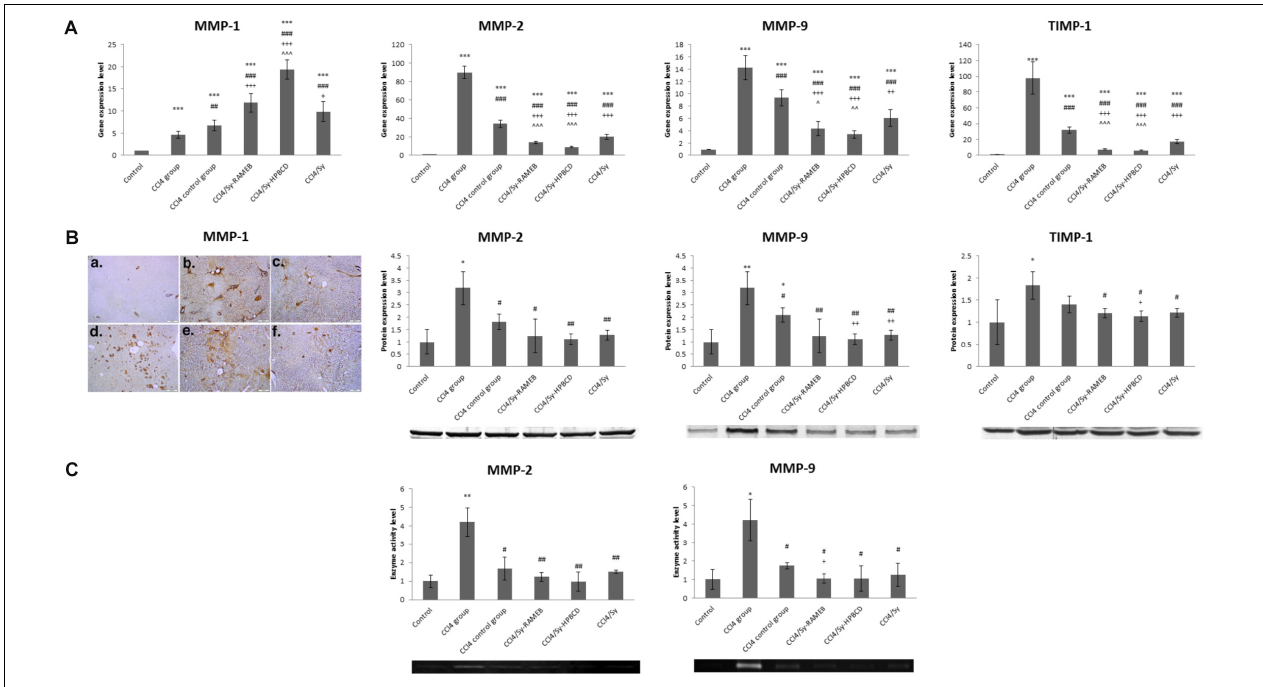
FIGURE 9 | Effects of Sy-HPBCD and Sy-RAMEB complexes on TIMP-1/MMPs modulation. (A) RT-PCR analysis of MMP-1, MMP-2, MMP-9, and TIMP-1 mRNA expression levels. (B) Immunohistochemical expression of MMP-1 and Western Blot analysis of MMP-2, MMP-9, and TIMP-1 protein expression levels. (C) Zymography analysis of MMP-2 and MMP-9 enzyme activity levels. ∗ p < 0.05, ∗∗ p < 0.01, ∗∗∗ p < 0.001 compared to control; # p < 0.05, ## p < 0.01, ### p < 0.001 compared to CCl 4 group; + p < 0.05, ++ p < 0.01, +++ p < 0.001 compared to CCl 4 control group; ˆ p < 0.05, ˆˆ p < 0.01 compared to CCl 4 /Sy group. ˆˆˆ p < 0.01 compared to CCl 4 /Sy